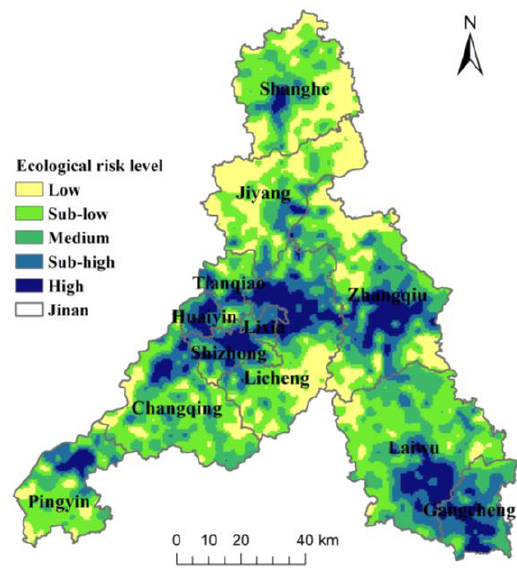
Figure 9. Spatial distribution of ecological risks.